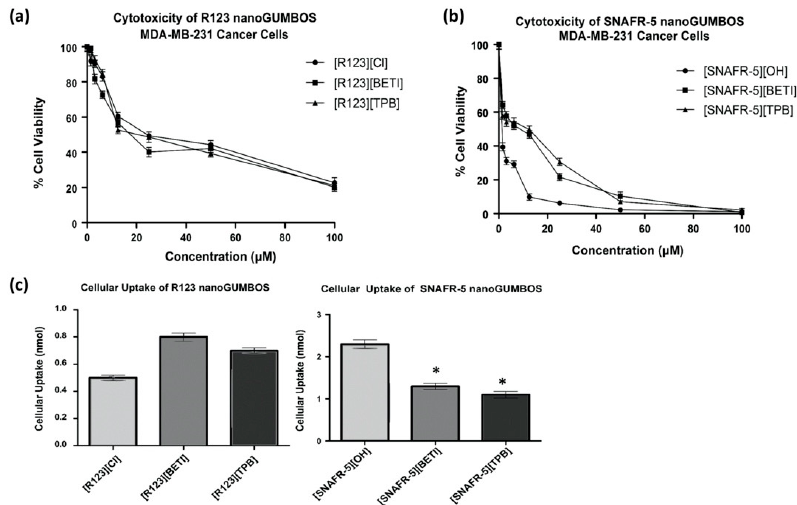
Figure 4. ( a ) Toxicity of R123 nanoGUMBOS towards MDA-MB-231 cancer cells; ( b ) Toxicity of SNAFR-5 nanoGUMBOS towards MDA-MB-231 cancer cells; ( c ) Cellular uptake of R123 nanoGUMBOS. (*) indicates significant difference in cellular uptake as compared to parent dye [SNAFR-5][OH] for respective nanoGUMBOS with p = 0.05.